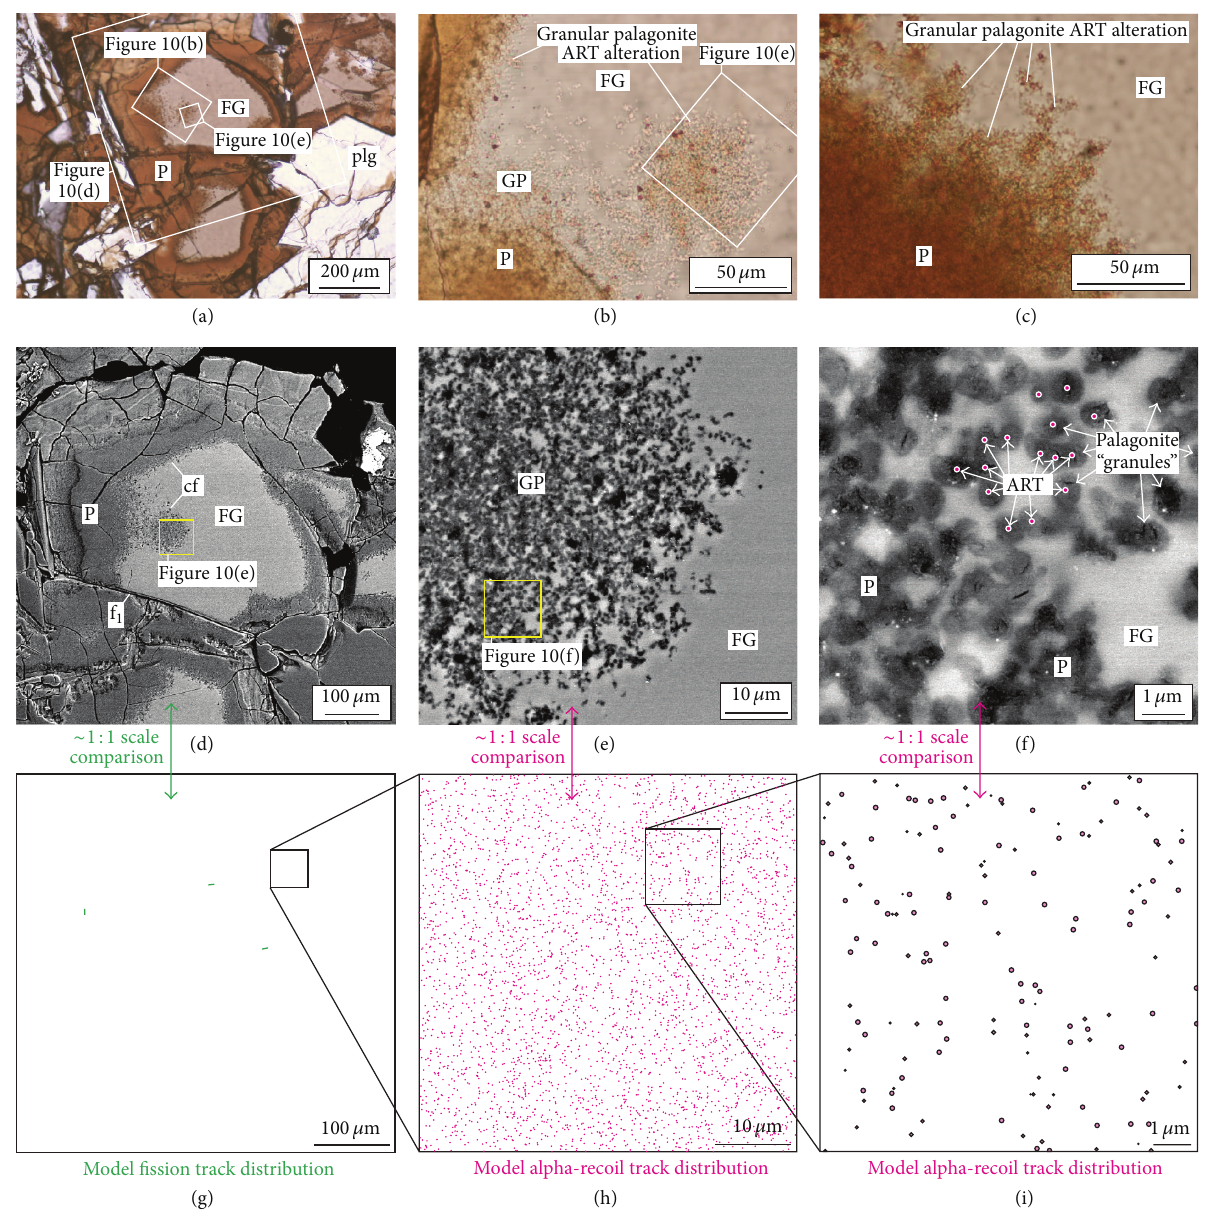
Figure 10: Petrographic, SEM, and theoretical modelling study of “granular palagonite ART alteration” microtexture in DSDP 418A basaltic glass. (a–c) Thin section photomicrographs (in plane polarized light) of samples DSDP-418A-68-3[40–43] (a, b) and DSDP-418A-75-3[120– 123] (c), highlighting “granular palagonite ART alteration.” (d–f) Close-up SEM (BSE) images from (a, b). (g–i) Theoretical plots of model fission track (g) and alpha-recoil track (h, i) areal distributions in DSDP 418A basaltic glass (calculated using (1) and (2); fission tracks are shown in green (g) and alpha-recoil tracks in pink (h, i)). The model track distributions in (g–i) are shown at approximately the same scale as the SEM images in (d–f), respectively—see green and pink arrows. Note that fission tracks are quite sparse (g), but alpha-recoil tracks are quite abundant and correlate very well with the observed pattern of development and areal distribution of ∼ 0.3–1.0 𝜇 m palagonite “granules” (i.e., compare (h) and (e), and (i) and (f)), thus indicating that, during corrosion of basaltic glass by seawater, granular palagonite microtextures develop through selective palagonitization of alpha-recoil tracks (and not microbial activity). To emphasize this idea, several hypothetical, previously existing alpha-recoil tracks (120nm pink dots) are plotted in (f), which would have acted as ideal “point sources” of radiation damage amenable to preferential corrosion/palagonitization. ART: alpha-recoil track; cf: corrosion front; f 1 : early fractures associated with palagonite; FG: fresh basaltic glass; GP: granular palagonite ART alteration; P: palagonite; plg: